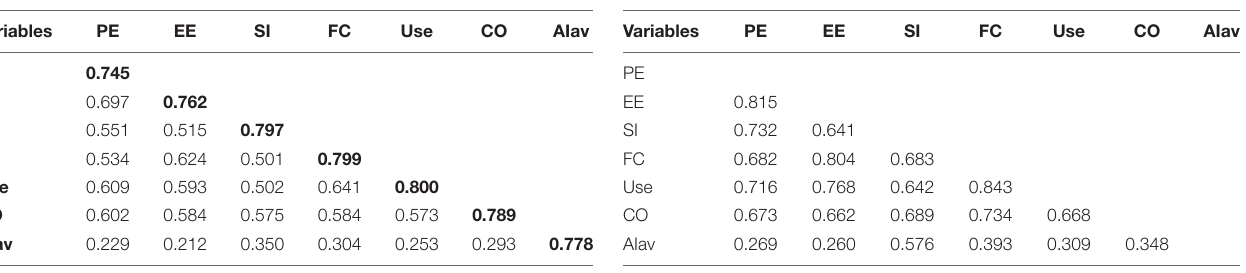
TABLE 3 | Fornell–Larcker criterion test of discriminant